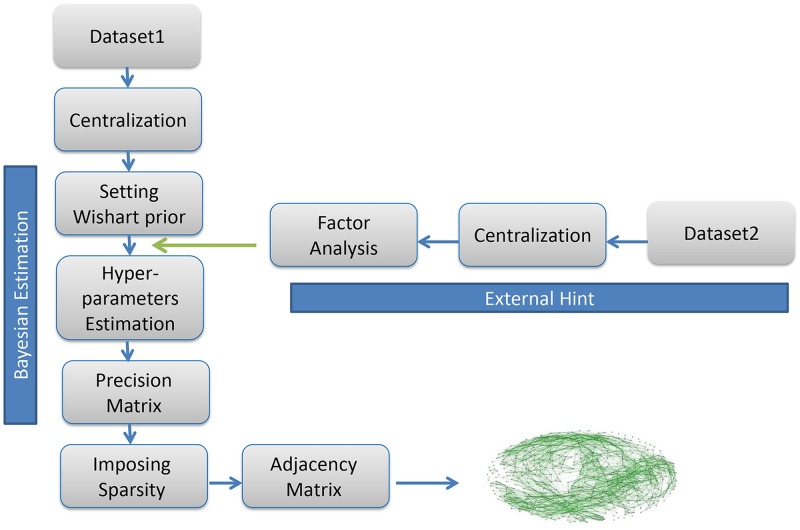
Overview of F-MAP algorithm.